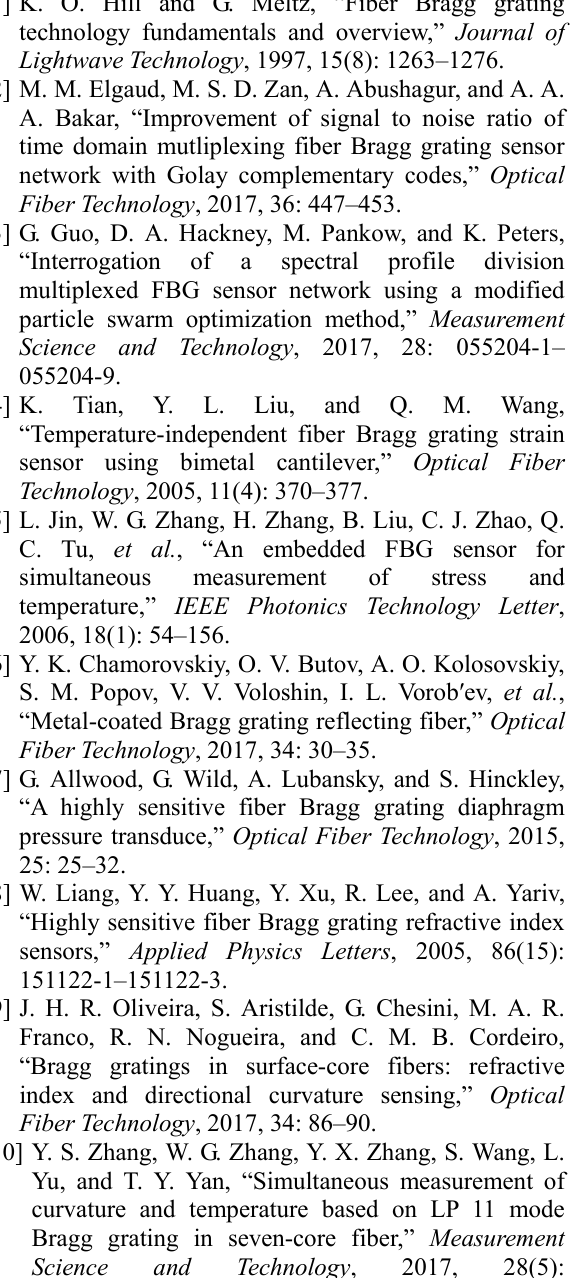
Relative error of the two methods (%)